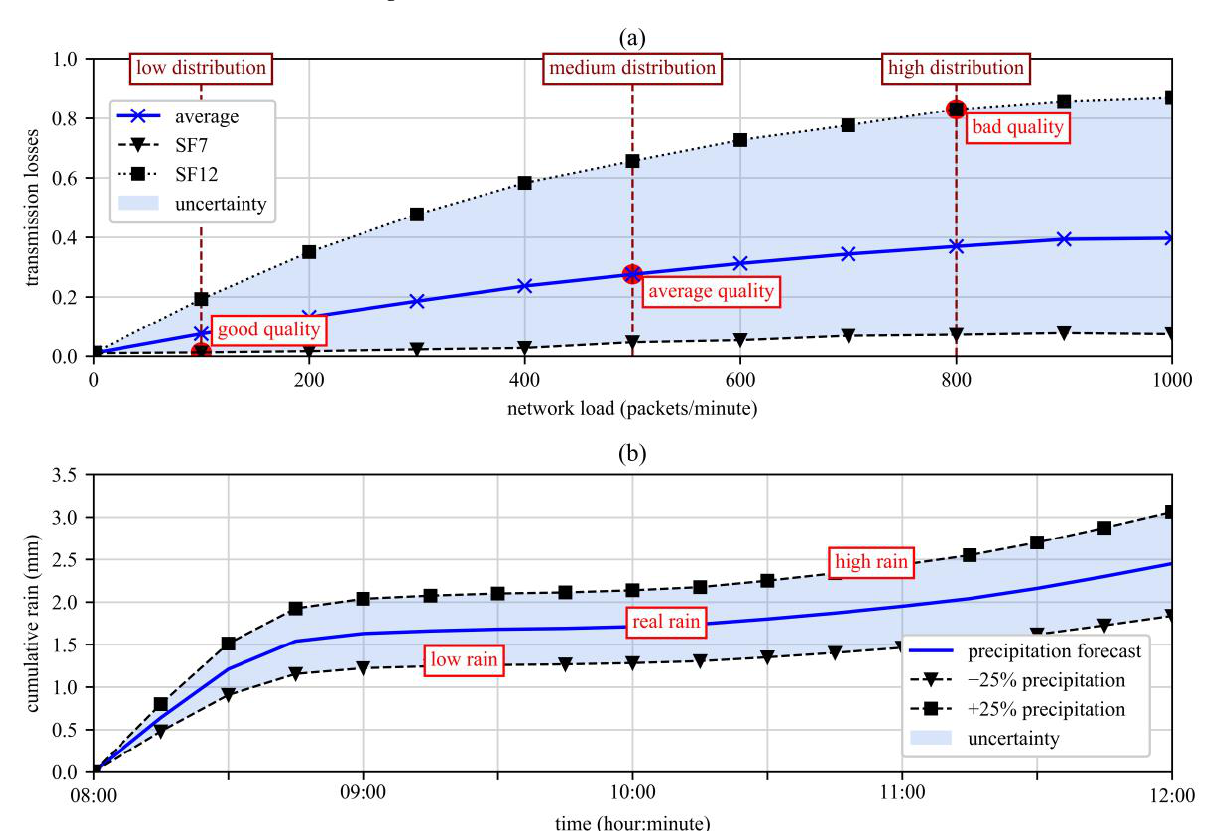
Figure 2. Illustration of considered digital uncertainty scenarios for smart RWH systems ( a ) for different connection quality and network loads for the communication technology LoRaWAN based on the results of [27]; and ( b ) real rainfall forecasts including a deviation of ± 25% illustrated for a real rain